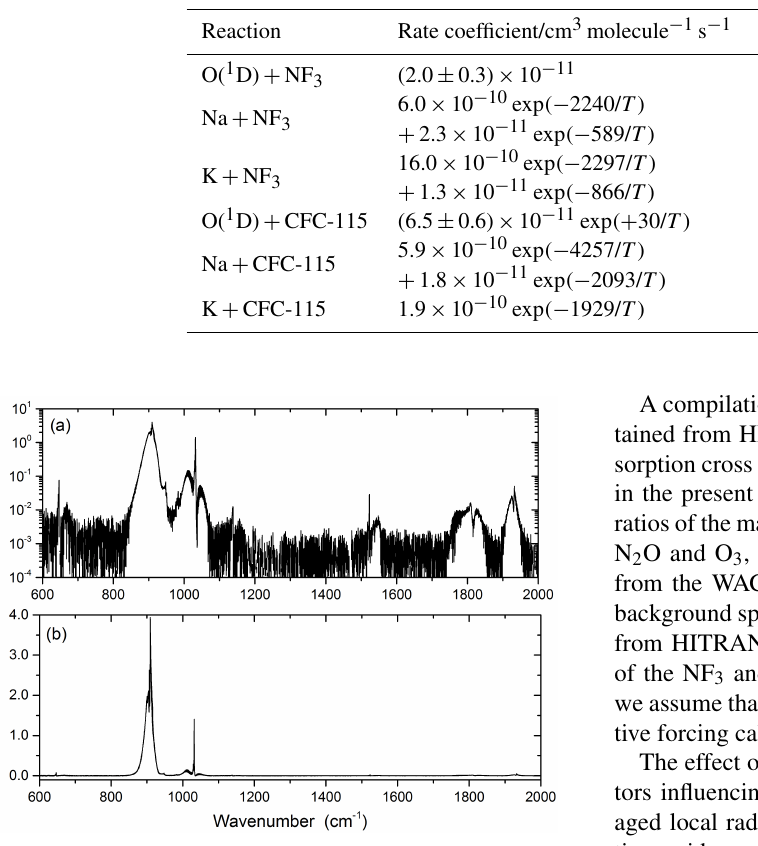
Table 1. Metal atom and O( 1 D) reactions with NF 3 and CFC-115 added to the WACCM chemistry module.